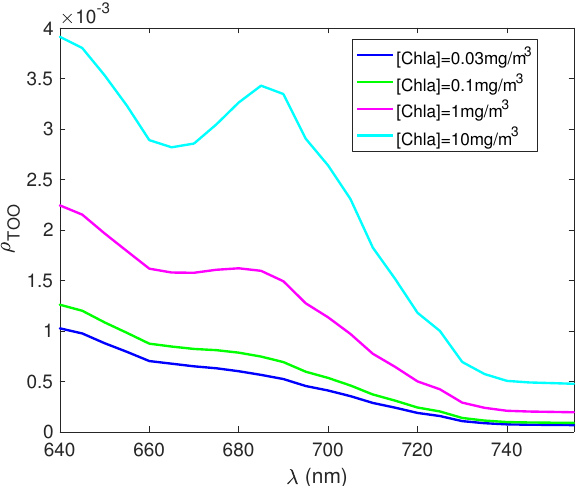
Figure 3. The nadir viewing reflectance at TOO as a function of wavelengths. The aerosol optical depth at 550 nm is 0.1 and the solar zenith angle is 30 ◦